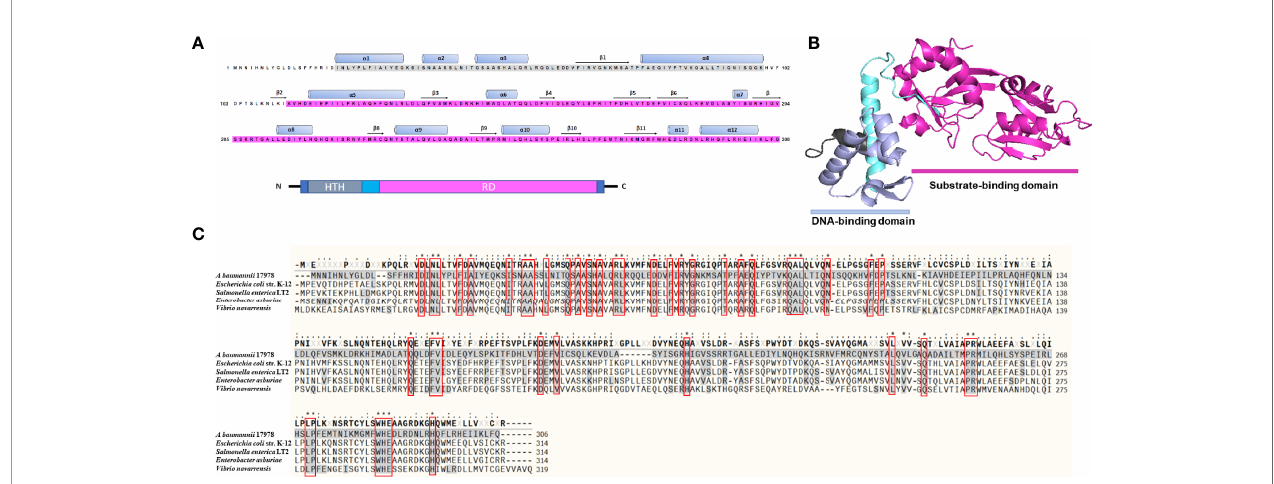
FIGURE 1 | Predicted three-dimensional structure and sequence alignment of LeuO. (A) Deduced amino acid sequence of A1S_1874 where the ash box indicates the helix-turn-helix DNA-binding domain (25 – 79) and the purple box indicates the LysR family substrate-binding domain (112 – 304). (B) Predicted 3D structure of A1S_1874 obtained using protein modeling server Phyre2 and PyMoL program. (C) Multiple sequence alignment using COBALT: Multiple Alignment Tool of A . baumannii A1S_1874 with previously characterized LTTR member LeuO from E. coli strain K-12 , Salmonella enterica LT2 , Enterobacter asburiae , and Vibrio navarrensis . “ * ” , “ . ” , “ : ” indicate most conserved residues and semi-conserved sequence,